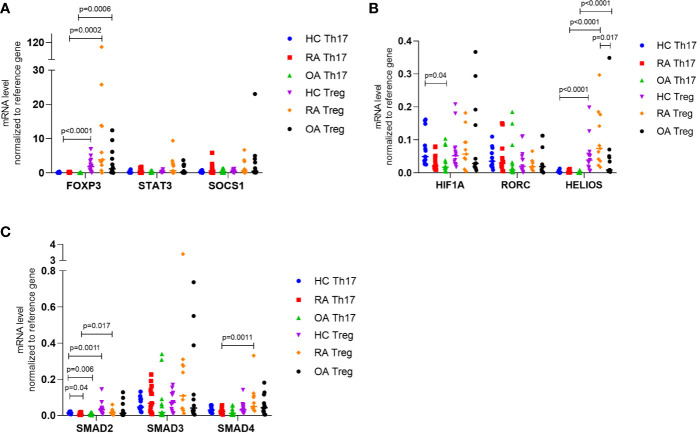

(A)
FOXP3, STAT3, SOCS1; (B)
HIF-1A, RORC, HELIOS; (C)
SMAD2, SMAD3, SMAD4 expression in FACS-sorted Th17 and Treg cells in RA, OA and HC normalized to housekeeping gene (RPLO). Data were presented as individual points with median. Significance at p < 0.05 (multiple comparison Kruskal-Wallis test with Dunn’s post hoc between HC, RA and OA; Mann-Whitney test between Th17 and Treg cells).